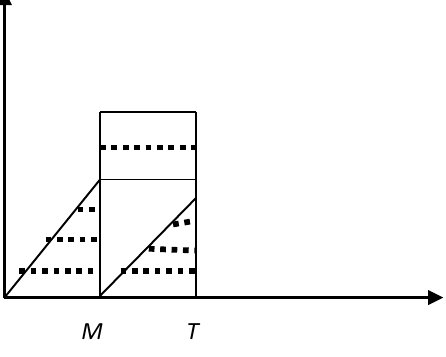
Fig. 9. Interest earned in sub case